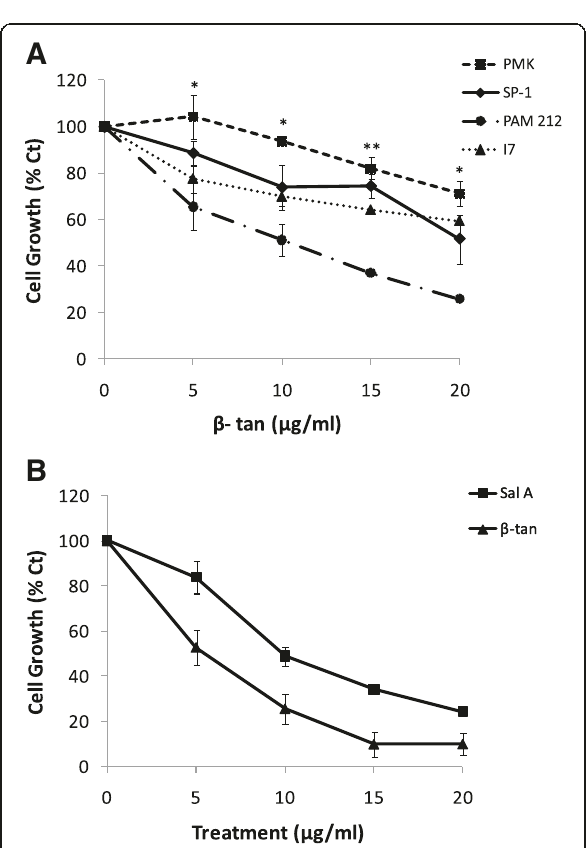
Figure 2 β -tan and Sal A selectively inhibit the growth of JB6P+ cells. At 50 – 60% confluency, primary mouse keratinocytes (PMK), SP- 1, PAM212, I7 (A) and JB6 P+ (B) cells were treated with the indicated β -tan or Sal A concentrations, or 0.1% ethanol as the control. Cell growth was determined at 24 h and expressed as percentage of control (Ct) treated cells using the MTT Cell Proliferation Kit, as described in Materials and Methods. Significance between neoplastic cell lines and PMKs is indicated by * at p < 0.05 or ** at p < 0.01. Results represent the mean (± SEM) of at least two independent experiments done in triplicate